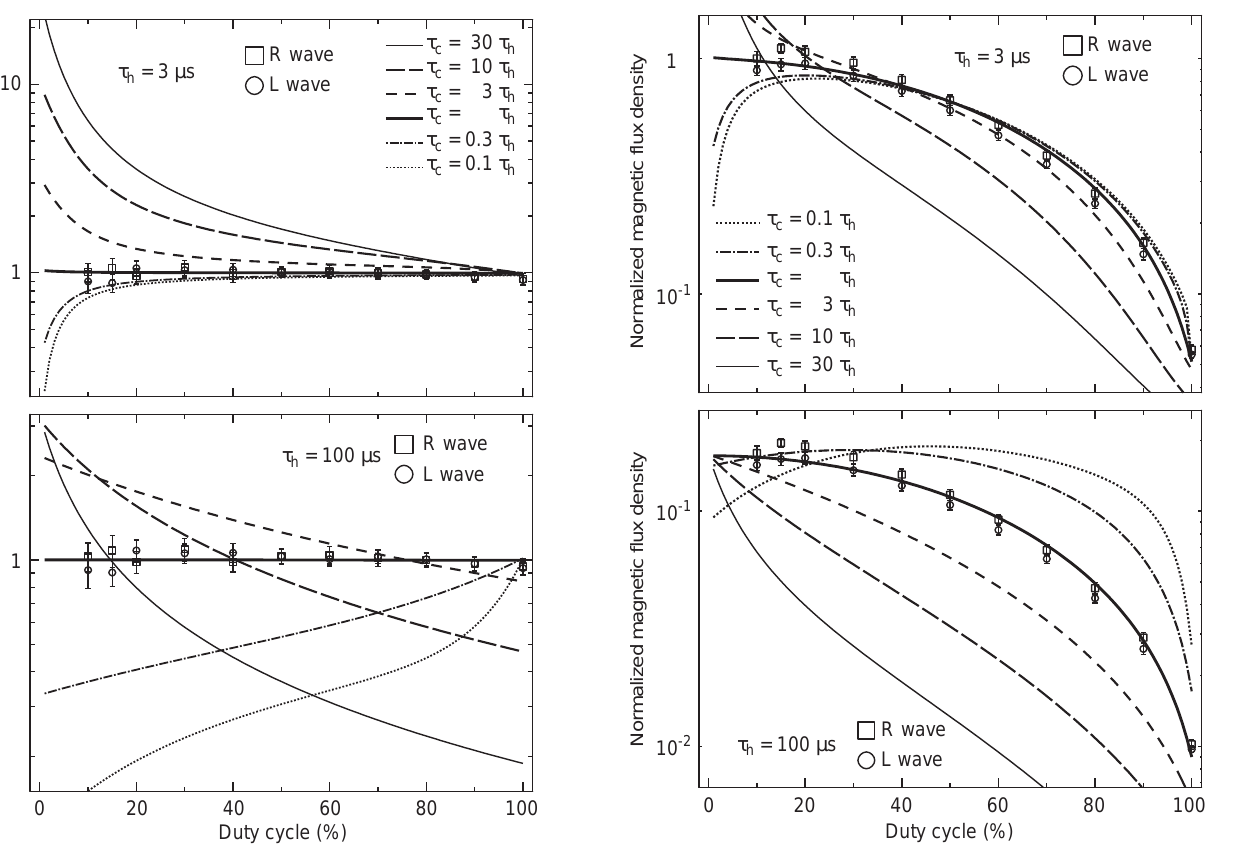
Fig. 6. Theoretical estimates of normalised magnetic flux density at 505 Hz produced by modulated ionospheric currents, plotted for a range of six cooling time constants. Upper panel data computed for a heating time constant of 3 l s. Lower panel data computed for a heating time constant of 100 l s. The square and round markers , with their associated error bars , represent the experimentally measured ‘R’ and ‘L’ wave normalised magnetic flux densities respectively